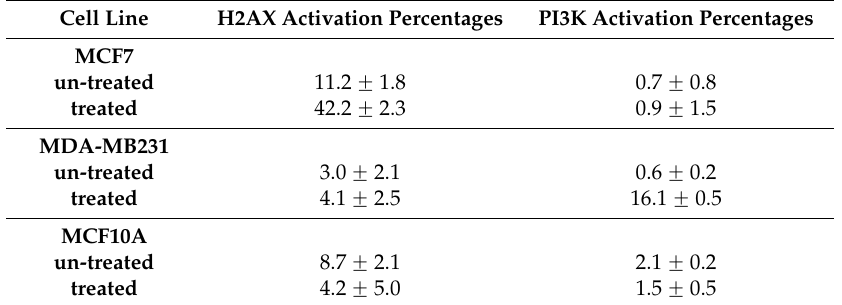
Table 4. H2AX and PI3K activation (expressed as percentages) for each cell population compared to the total cell population for MCF7, MDA-MB231 and MCF10A cells before and after treatment with 63 µ g/mL, 64.5 µ g/mL and 64.5 µ g/mL of phenolic extract from FS oil. The data are reported as mean value plus/minus the standard